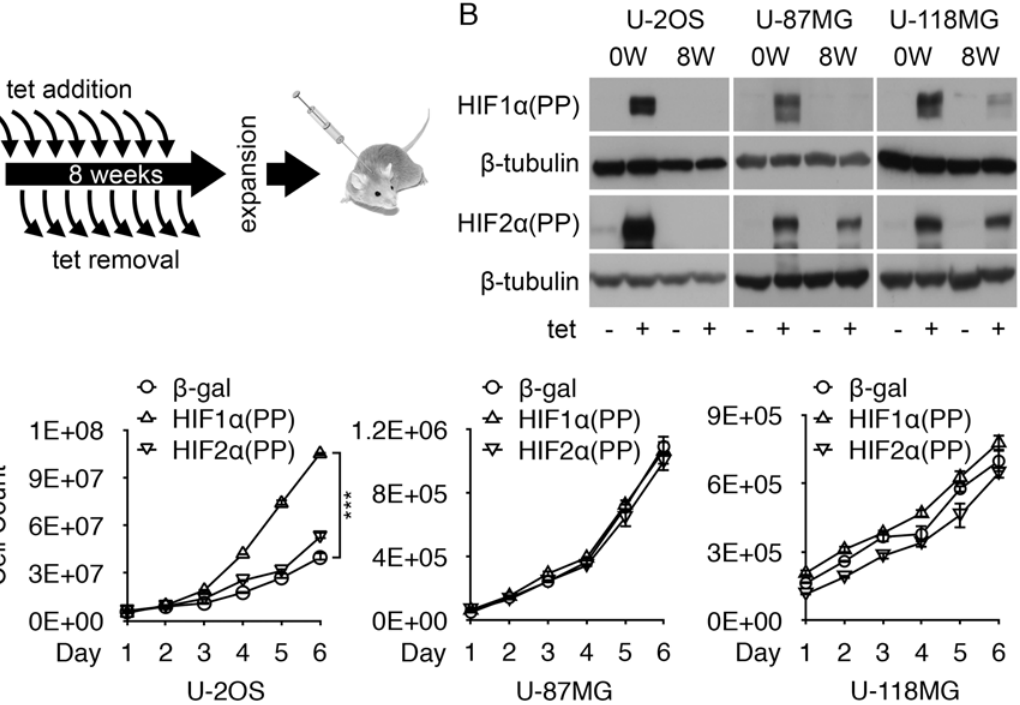
Fig 2. Intermittent induction resulted in loss of of HIF1 α (PP) expression. (A) Intermittent induction involves the administration of tetracycline into cell culture each week on day 1 and removal on day 4 each week for a total of 8 weeks. Afterwards, cells were allowed to expand for further analyses and injections. (B) After intermittent induction (8W), different types of cells as indicated were induced again with tetracycline for 2 days and analyzed by Western blotting in reference to those without intermittent induction (0W). (C) Cell proliferation was determined by cell counting after intermittent induction. *** , p -value <